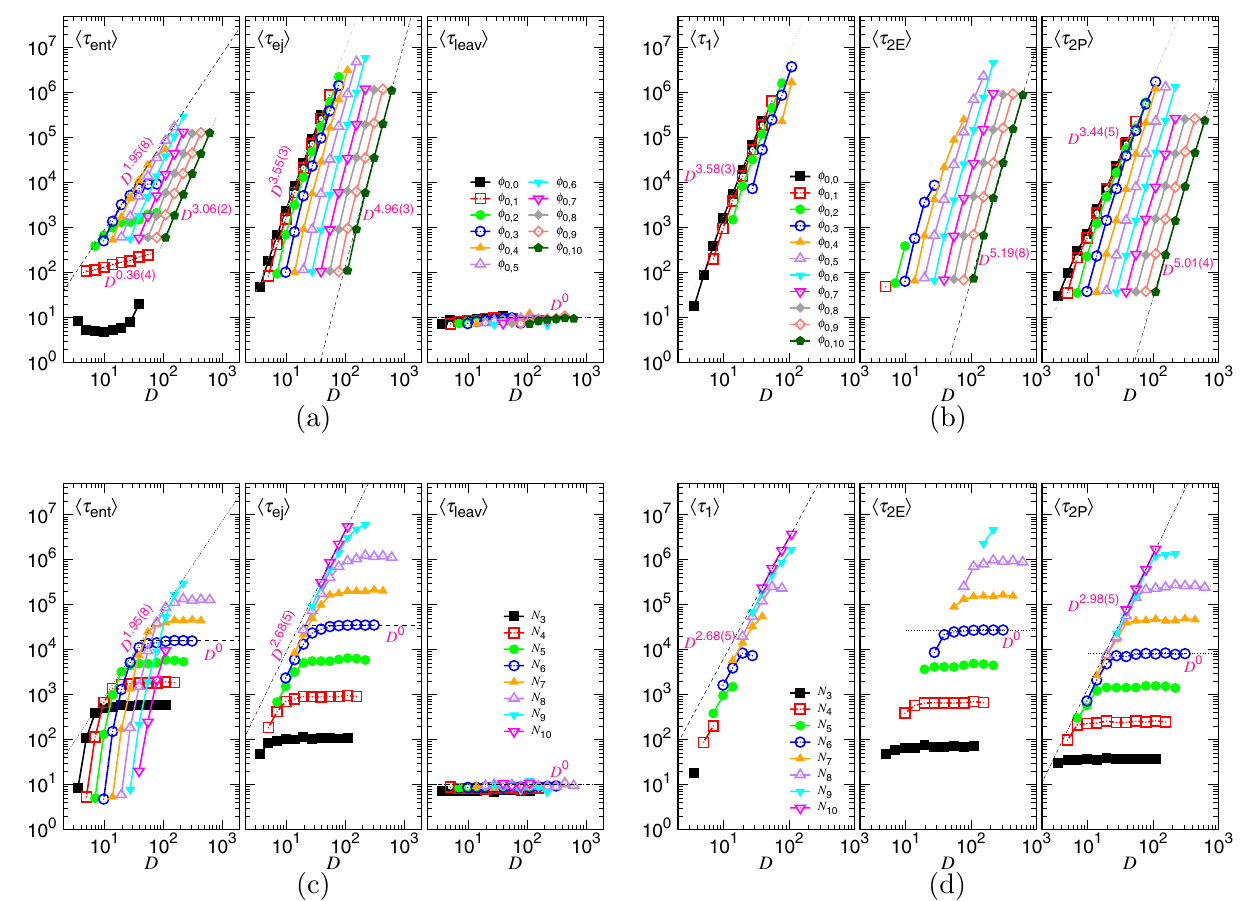
τ ej τ ent τ leav τ 1 τ 2E τ 2P Figure 15. ( a ) , , , and ( b ) , , as a function of D , plotted under the φ 0 -fixed (cid:31) (cid:30) (cid:31) (cid:30) (cid:31) (cid:30) (cid:31) (cid:30) (cid:31) (cid:30) (cid:31) (cid:30) τ ej τ ent τ leav 0.3 2 − j . (c) condition. The value of φ 0 can be read in the legends, calculated by φ 0, j , , , and = × (cid:31) (cid:30) (cid:31) (cid:30) (cid:31) (cid:30) τ 1 τ 2E τ 2P (d) , , as a function of D , plotted under the N -fixed condition. The chain length N can be read in (cid:31) (cid:30) (cid:31) (cid:30) (cid:31) (cid:30) 2 i the legends where N i = 0.18 smaller lie basically on a line N 2.58 ( 3 ) . It has been shown in Fig. 6 that z 2E is about 1.18, which gives y 2E ≃ τ 2E τ 2P than x 1 . The dominated scaling for is thus N 2 + x 1 according to Table 1. The time is expected to show (cid:31) (cid:30) (cid:31) (cid:30) N 1 + z 2P for N > 2 N and N 1 + z 2P for N < 2 N . Again, the obtained exponents, 1.72(5) at the large φ 0 and 2.54(2) ∗ ∗ ∗ 1.67 and 1 z 2P 2.5 , respectively. at the small φ 0 in Panel (d), are quite close to the theoretical values 1 + z 2P d ν ≃ + = The variations of the different time components versus D for the φ 0 -fixed and N -fixed conditions are given in φ 0,1 τ ent 0.15 . Decreasing φ 0 moves upward the curve Fig. 15. We see in Panel (a) that scales as D 0.36 ( 4 ) at φ 0 = ≡ (cid:31) (cid:30) in a parallel manner. The curve is then “reflected” toward right after meeting the demarcating line D 1.95 ( 8 ) , and 2 σ N the scaling changes to D 3.06 ( 2 ) . The results are consistent with the ones in Fig. 14c because φ 0 which D ∼ yields the scaling exponent for D about twice of the one for N at a given φ 0 value. Similarly, the ejection time (cid:30) (cid:31) τ ej scales like D 3.55 ( 3 ) at large φ 0 and D 4.96 ( 3 ) at small φ 0 . The two exponents are about twice of the ones found (cid:31) (cid:30) τ leav in Fig. 14c. The leaving time stays small and is about constant with varying D . (cid:31) (cid:30) τ 1 D 3.58 ( 3 ) (hap- The components of the ejection time in Panel (b) show the following scaling behaviors: � � ∼ τ 2E τ 2P D 5.19 ( 8 ) (happened when φ 0 is small), and D 3.44 ( 5 ) at large φ 0 and D 5.01 ( 4 ) pened when φ 0 is large), � � ∼ � � ∼ at small φ 0 . The exponents are found to be the double of the ones in Fig. 14d. σ N ν τ ent Figure 15c reveals that grows faster than a power law when D is smaller than the critical value D (cid:31) (cid:30) ∗ ∼ τ ent and becomes horizontal when D > D , if N is fixed. The scaling line D 1.95 ( 8 ) in the figure tells how varies at (cid:31) (cid:30) ∗ τ ej the critical diameter. The ejection time grows initial as D 2.68 ( 5 ) , following the predicted behavior D 2 /ν , and (cid:31) (cid:30) τ 1 τ 2 E turns to becomes horizontal as D > D . Panel (d) shows that the component exhibits a D 2.68 ( 5 ) scaling. (cid:31) (cid:30) (cid:31) (cid:30) ∗ τ 2 P is about constant in the concerned large D region and possesses the exponent value 2.98(5) for D < D and (cid:31) (cid:30) ∗ turns to be leveled-off for D > D . The previous exponent is close to the theoretical value 1 + z 2P ν . ∗ Figure 16 presents the variations of the different time components against the initial volume fraction φ 0 . With N being fixed, Panels (a) and (b) are, in fact, the replots of Fig. 15c,d through the abscissa mapping φ 0 τ ent N (σ/ D ) 2 . In the plots, is flat in the small φ 0 region and decreases quickly as φ 0 passes a critical value ≃ (cid:31) (cid:30)